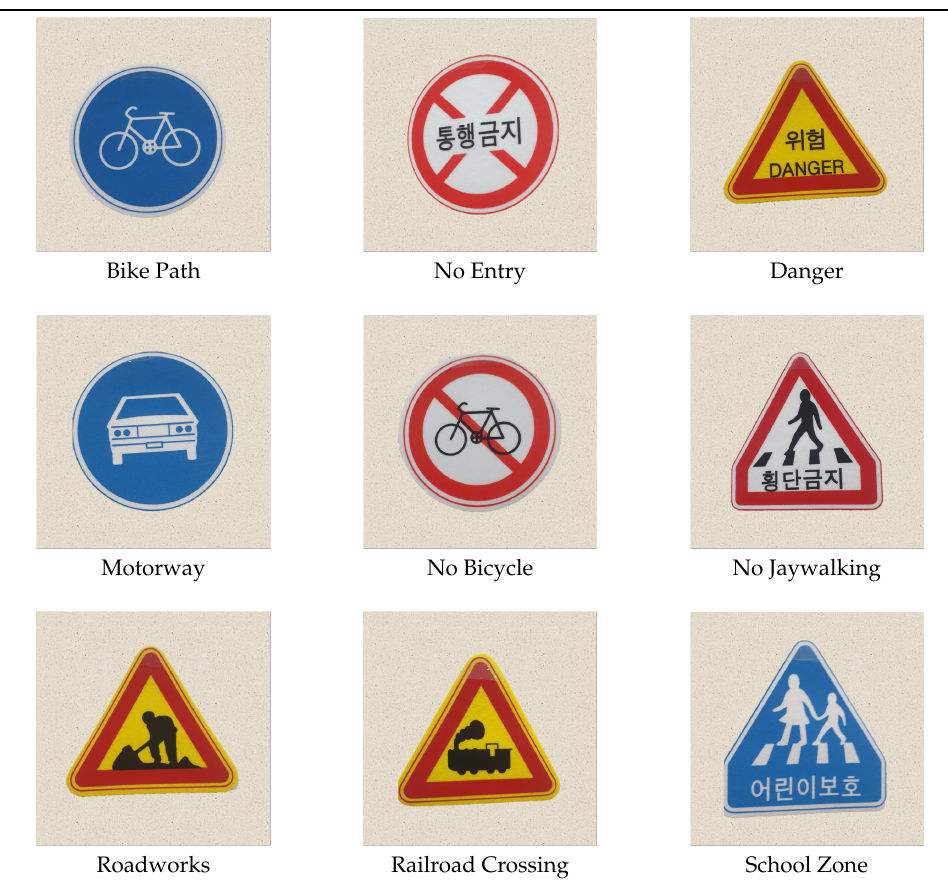
Table 2. Korean traffic sign mock ups used in the physical-world attack experiment against classifica- tion